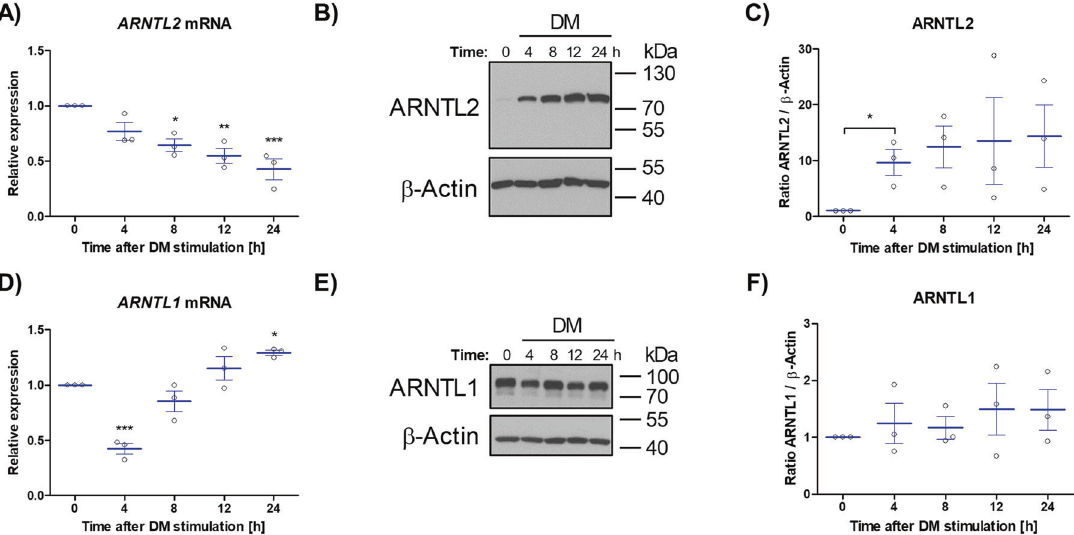
Fig. 3 Impact of short-term stimulation of ASCs with adipogenic differentiation medium on ARNTL1 and ARNTL2 expression. A ARNTL2 mRNA expression. Values are given as mean ± SEM of n = 3 individual donors. Statisitcal analysis between groups was achieved using One- way ANOVA with Dunnett´s multiple comparison test. B A representative ARNTL2 Western blot of n = 3 different donors is shown. β -Actin served as loading control. C Densitometric quanti fi cation of ARNTL2 Western blots of n = 3 individual donors. Values are shown as mean ± SEM. Statistical comparison was done with the paired t test. D ARNTL1 mRNA expression. Values are given as mean ± SEM of n = 3 individual donors. Statisitcal analysis between groups was achieved using One-way ANOVA with Dunnett´s multiple comparison test. E A representative ARNTL1 Western blot of n = 3 different donors is shown. β -Actin served as loading control. F Densitometric quanti fi cation of ARNTL1 Western blots of n = 3 individual donors. Values are shown as mean ± SEM. Note: scaling of y -axis is different in ( C ) and ( F ). DM differentiation